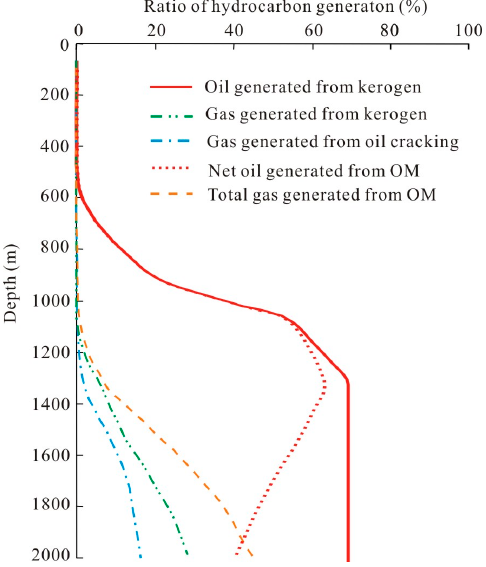
Figure 6. The hydrocarbon generation profile of K 1 yc 4 in the South Shuangcheng Fault Depression.